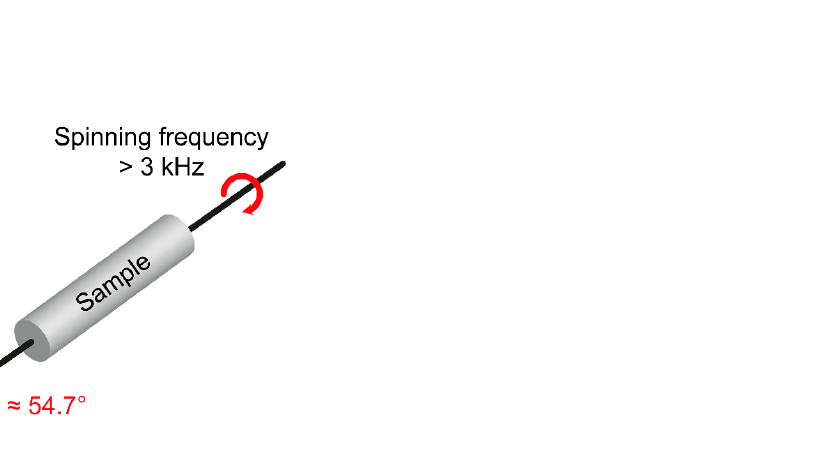
Figure 2. HR-MAS setup where the sample is rotated with high frequency (>3 kHz) tiled by the magic angle θ m with respect to the magnetic field (B 0 ). HR-MAS NMR is a combination of solid- and liquid-state NMR techniques, which can obtain spectra with similar resolution as spectra from liquid-state NMR experiments but make use of semi-solid samples with restricted molecular mobility [9]. Semi-solid samples, like biological tissues, can be used without extraction steps using this technique. In HR-MAS NMR, the effect of hetero- and homonuclear dipolar coupling is minimised at a frequency of a few kHz, while rigid solid samples need spinning frequencies of 20–50 kHz. 4. HR-MAS NMR-Based Workflow Here, we will explain in more detail an HR-MAS NMR-based workflow and apply the workflow to plant material. The HR-MAS NMR-based workflow is shown in Figure 3. The workflow starts with the harvesting of the leaves from plants for the prepa- ration of a sample in the rotor, followed by performing the HR-MAS NMR experiments. The pulse sequences which can be used in metabolomics are described in Section 5. The data are pre-processed and reduced by bucketing (Section 6). Multivariate analysis is ex- ecuted in three steps: the detection of outliers, investigation of the variation between dif- ferent samples, and the selection of potential biomarker candidates (Section 7). Finally, the biomarkers quantification and biological interpretation is explained in a comprehen- sive systems biology approach by using available information from the literature. This workflow is based on a recently established liquid-state NMR approach [10]. The infor- mation about pulse sequences, the pre-processing of the data and multivariate analysis is also applicable to liquid-state NMR data. The advantage of using HR-MAS NMR spec- troscopy on leaves is that experiments can be genuinely performed in vivo , which will be illustrated with selected plant metabolomics applications (Section 8). As suggested re- cently, sample preparations and instrumental setup protocols need to be carefully stand- ardized in order to obtain highly reproducible and reliable data [11].